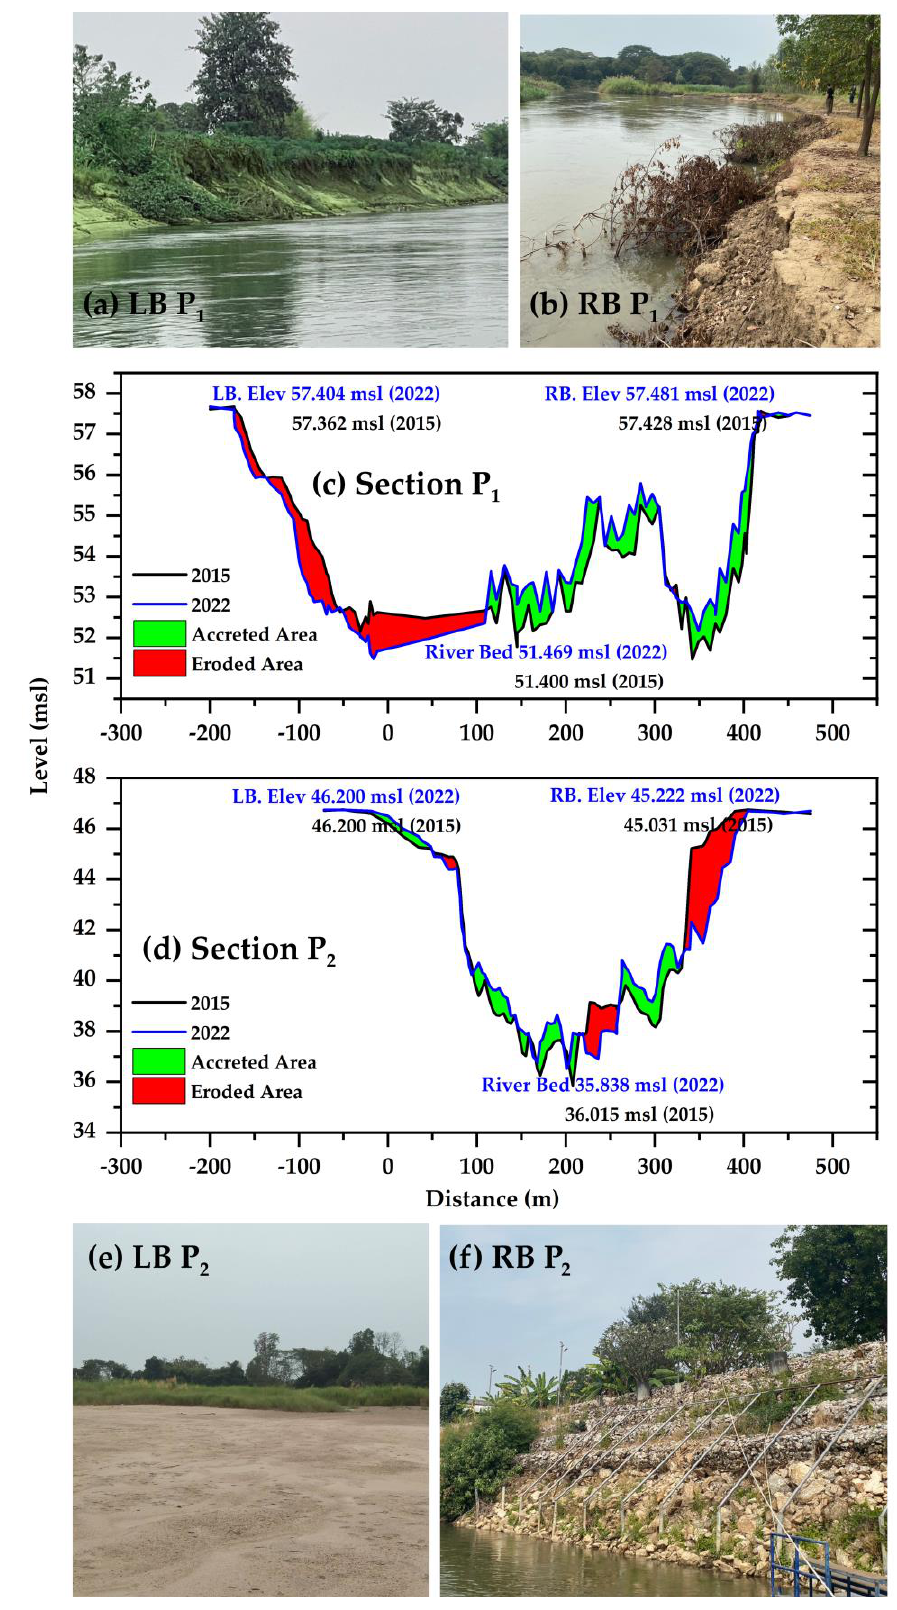
Figure 13. ( a ) Left and ( b ) right riverbank at station P 1 ; Ping River cross-section at ( c ) station P 1 and ( d ) station P 2 in 2015 (black line) and 2022 (blue line); ( e ) Left and ( f ) right riverbank at station P 2 ; Red (green) area denotes erosion (accretion).